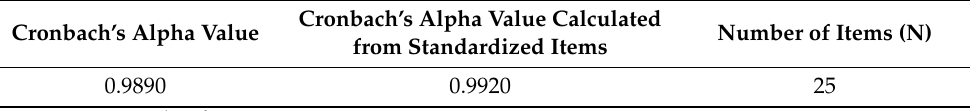
Table 3. Reliability and validity.